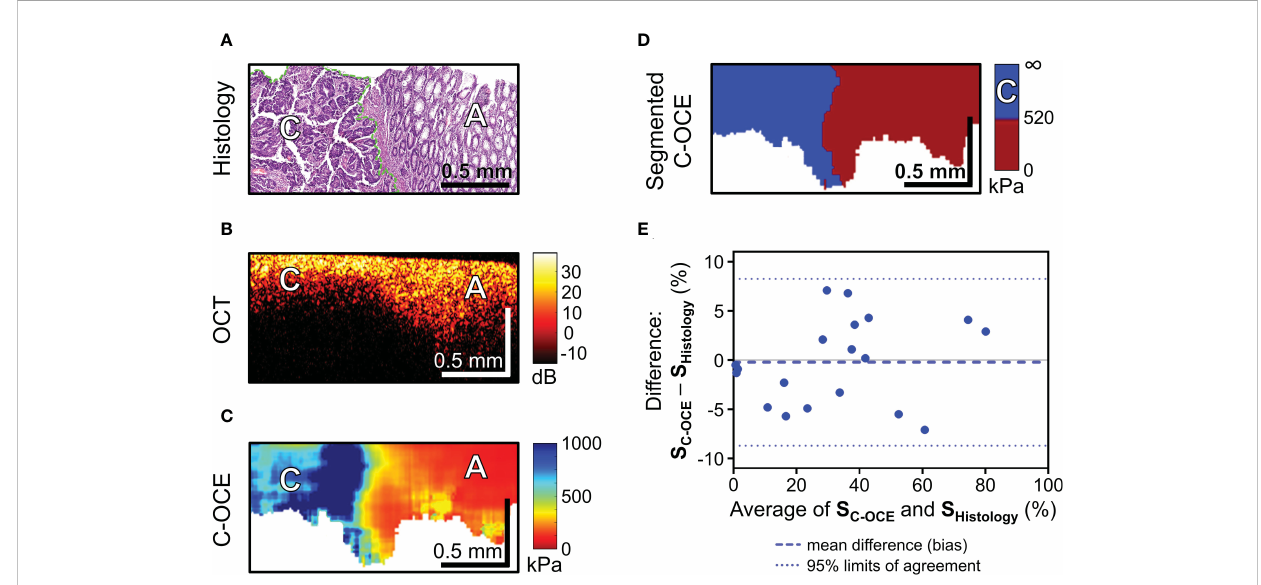
FIGURE 5 C-OCE identi fi cation of colorectal cancer border with non-tumorous tissue and correlation between C-OCE and histological data. Corresponding tissue areas in histological (A) , OCT (B) and C-O С E (C) images. (D) – segmented C-OCE image derived from stiffness C-OCE image (C) using the color palette and the characteristic stiffness of colorectal cancer cells >520 kPa; designations: [C] – cancer cells, [A] – adenoma; bar size is shown in the images. (E) – quantitative comparison of histological and C-OCE-based segmentation results presented in the form of a Bland Altman diagram. The diagram re fl ects the dependence of the established averages between the two methods of knowledge and the difference between the established values of the areas of colorectal cancer (SC-OCE – S histology, %); symbols: blue dotted line – bias (mean of systematic error), blue dotted lines – upper and lower 95% limits agreement. Additionally, a comparison between the areas of cancer cells identi fi ed by morphometric analysis by C-OCE and histology, shows a strong and direct correlation (Pearson correlation coef fi cient r=0.98; p